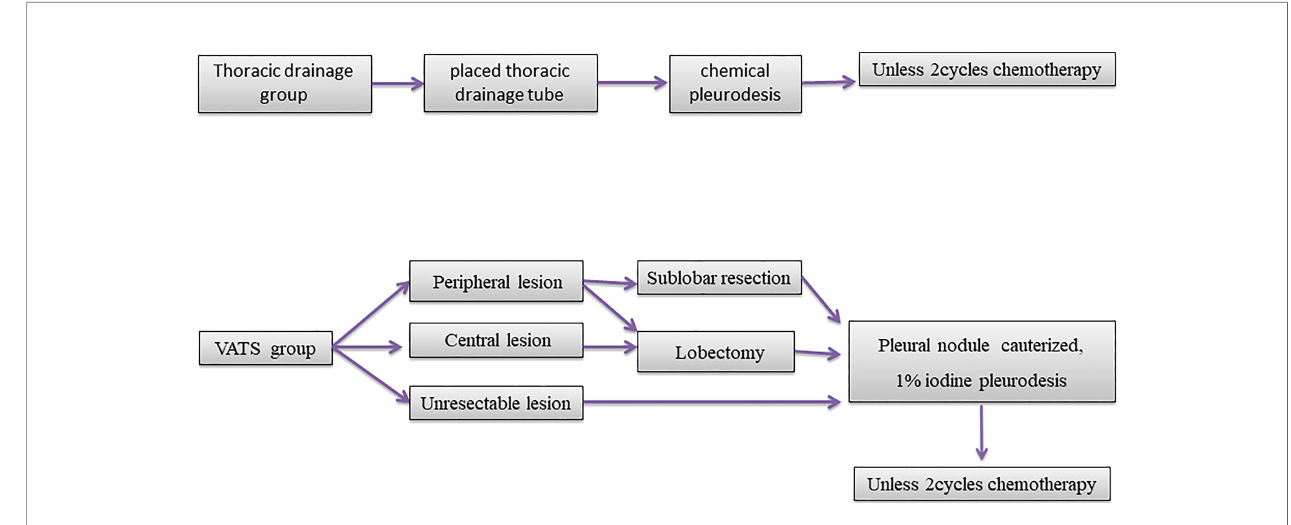
FIGURE 1 | Outline of two groups of patients with different treatment